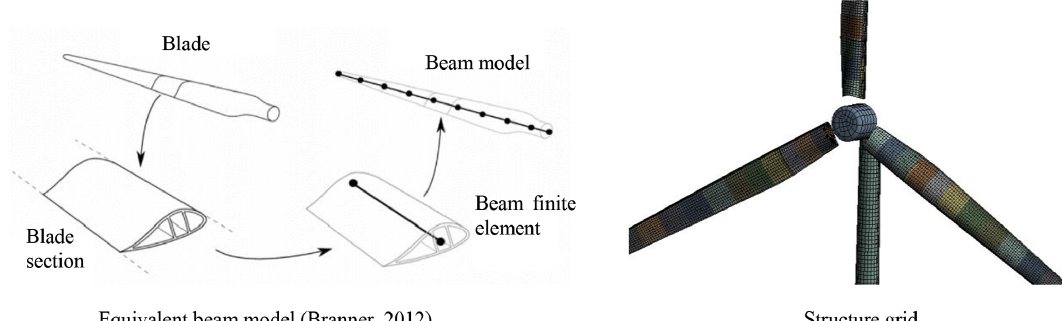
Figure 5. Wind turbine structure.